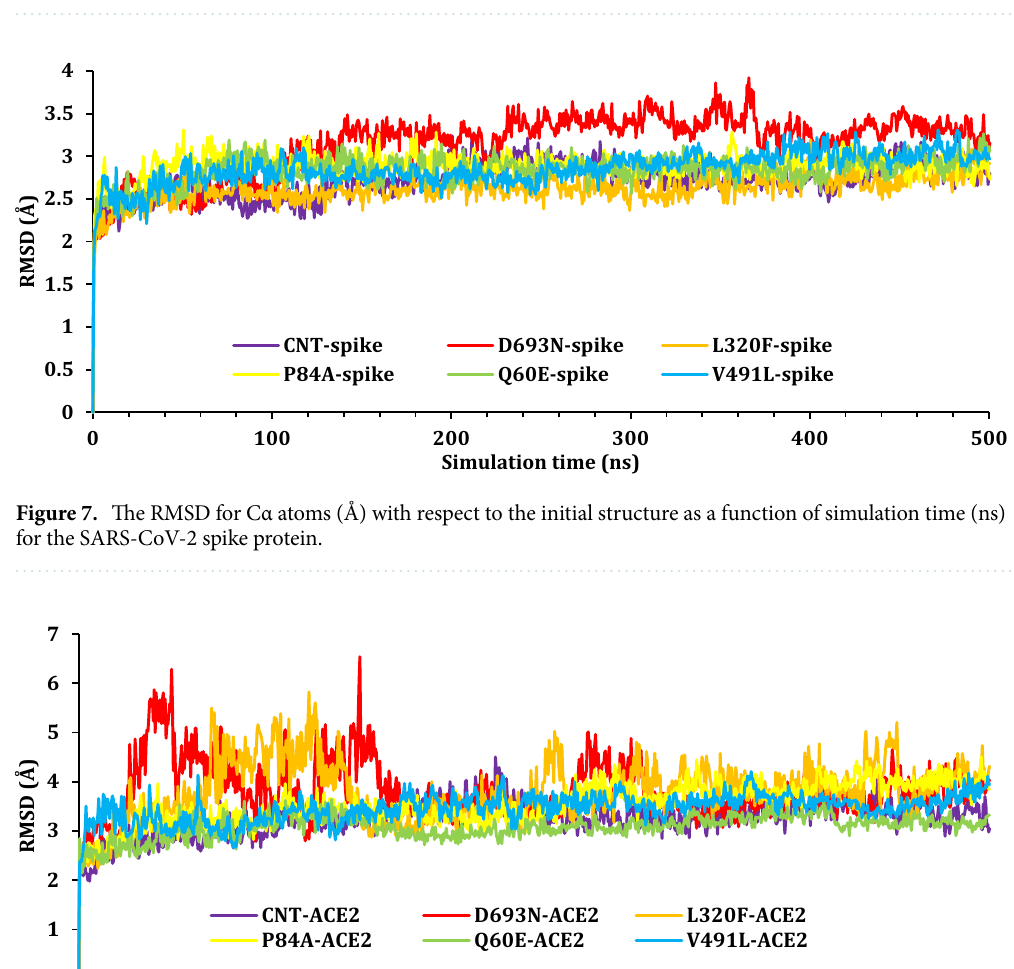
Figure 6. The RMSD for Cα atoms (Å) with respect to the initial structure as a function of simulation time (ns) for the six complexes.